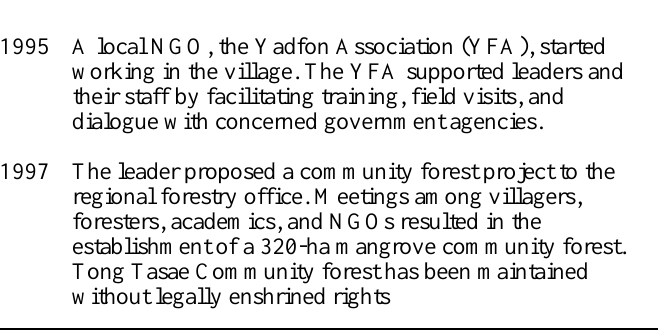
The mangrove community forest was enlarged to 80 ha and divided into three parts: a conservation zone, a utilization zone, and a medical zone. The village has been maintaining the mangrove community forest through to the present